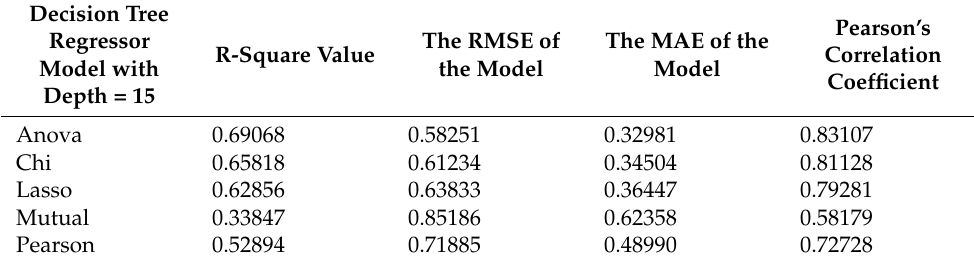
Table 9. Decision Tree